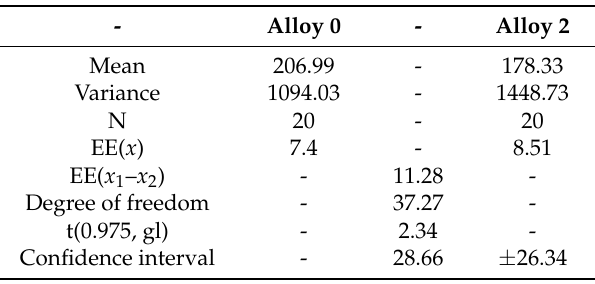
Table 4. Contrast of hypothesis for alloy 0 and alloy